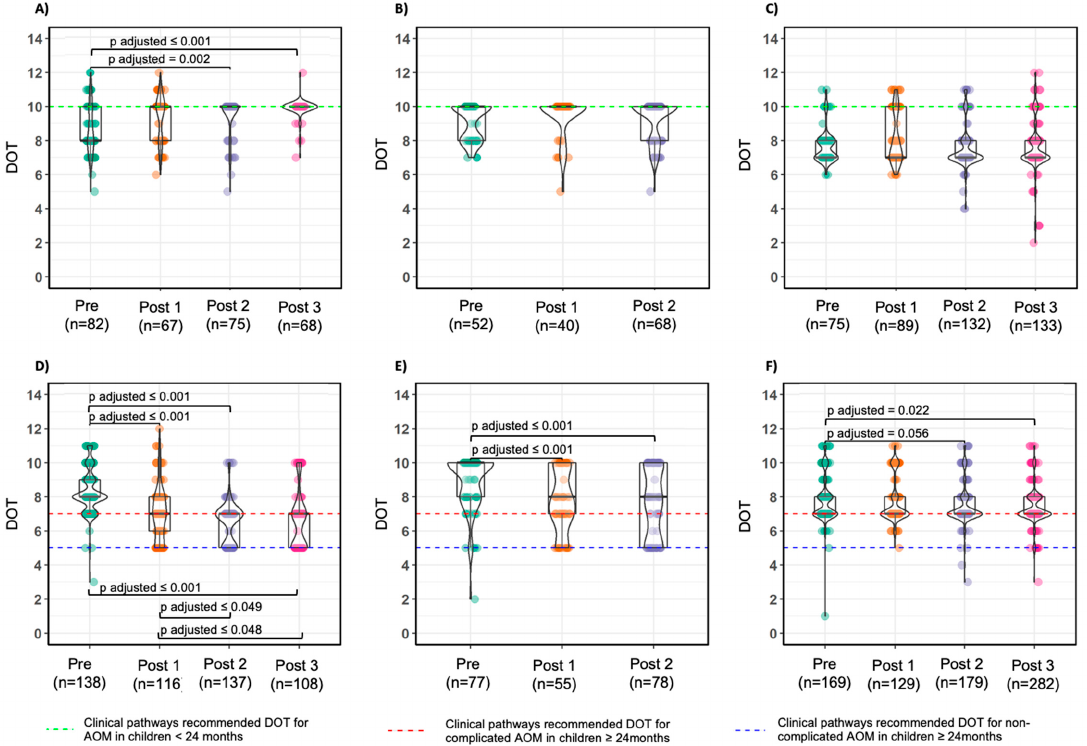
Figure 2. Distribution of days of therapy for non-complicated acute otitis media in the different periods in Center A ( A , D ), Center B ( B , E ), and Center C ( C , F ) stratified by age class (<24 months: A , B , C ; ≥ 24 months: D , E , F ) with pair-wise comparison. The dots represent the granular data, horizontal lines are median and IQR; whiskers extend to the minimum and maximum within 1.5 times the IQR. Violin plots present quantifications. The dotted green line represents the DOT recommended in the clinical pathways for acute otitis media in children <24 months, while the dotted blue line represents clinical pathways recommended DOT for non-complicated AOM in children ≥ 24 months and the dotted red line represents clinical pathways recommended DOT for complicated AOM in children ≥ 24 months .